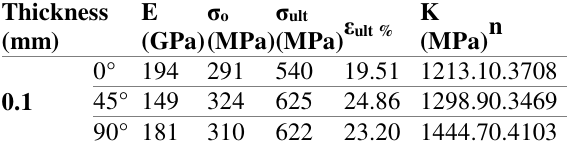
Mechanical properties of SS 304 foil.